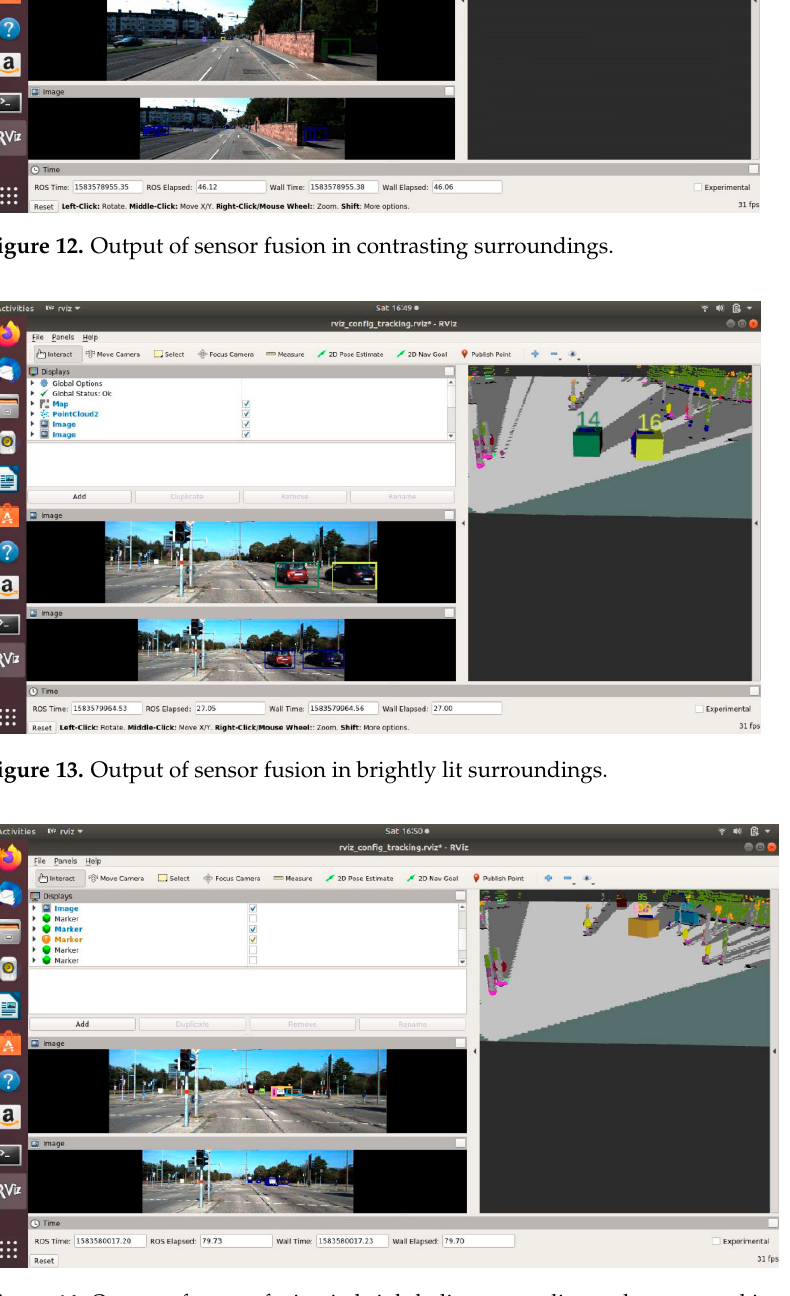
Figure 14. Output of sensor fusion in brightly lit surroundings when target objects are at a